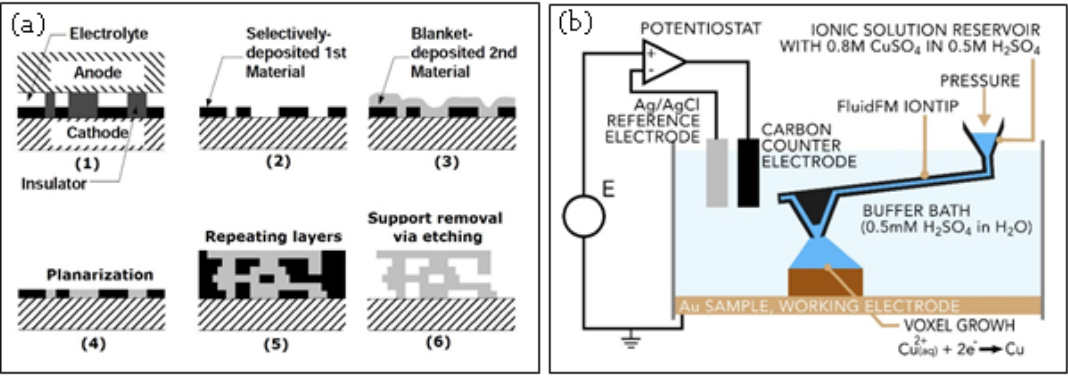
Figure 11. Schematic view of ( a ) EFAB [150] and ( b ) FluidFM printing cell. the iontip dispenses the